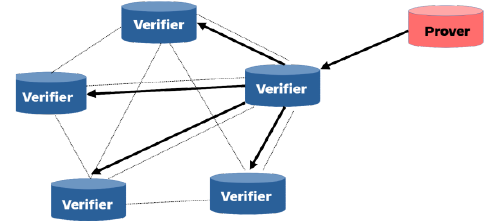
Figure 3: Delegated Computation in